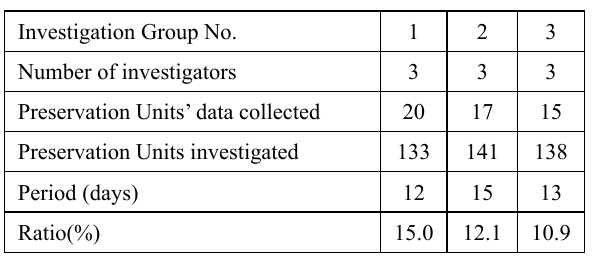
Table 1. Data collection efficiency in the general plan of Chifeng cultural heritages conservation